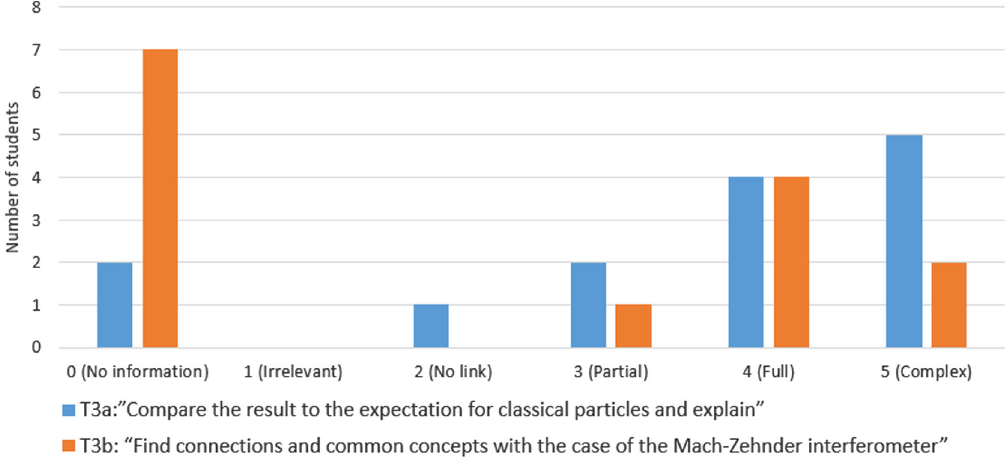
FIG. 4. Results for task T3 (wave particle duality in the context of Young ’ s experiment with one electron at a